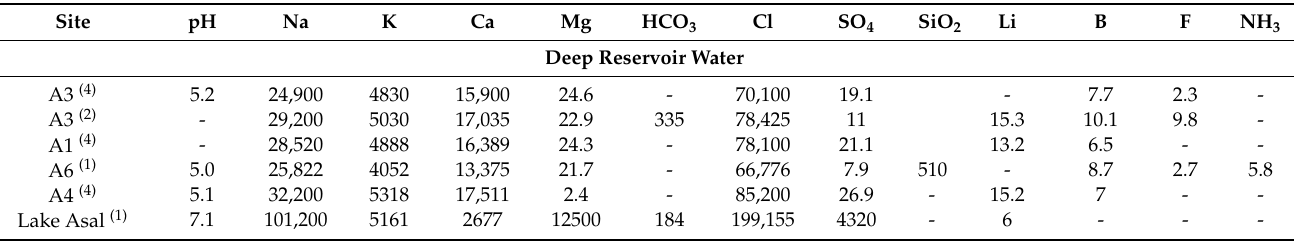
Table 2. Water compositions from Lake Asal and Asal wells. Concentrations are in mg/L. (1) [88]; (2) [91]; (4)